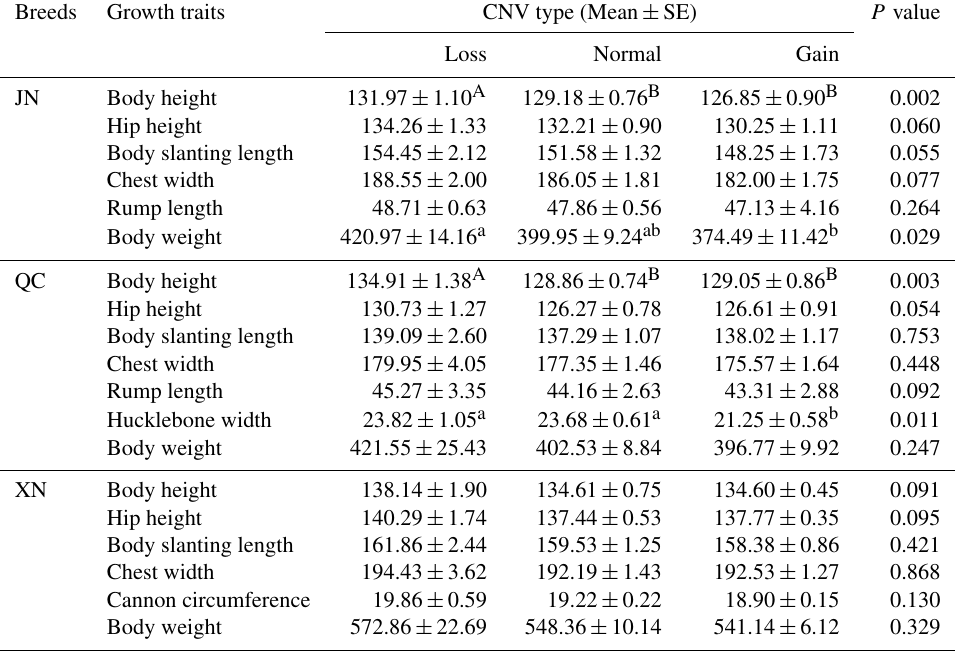
Table 2. Association analysis of IGF1R DNA copy number variation (CNV) types with growth traits in cattle.